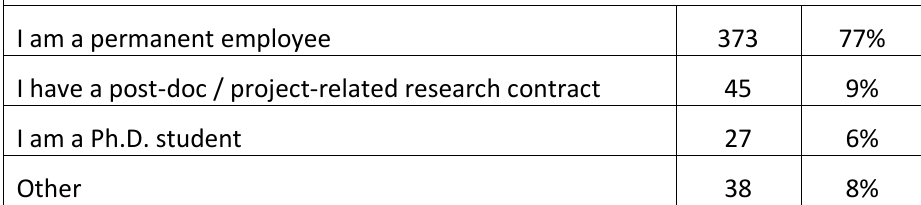
Table 4 : What describes best your current position in the organisation? ( N =